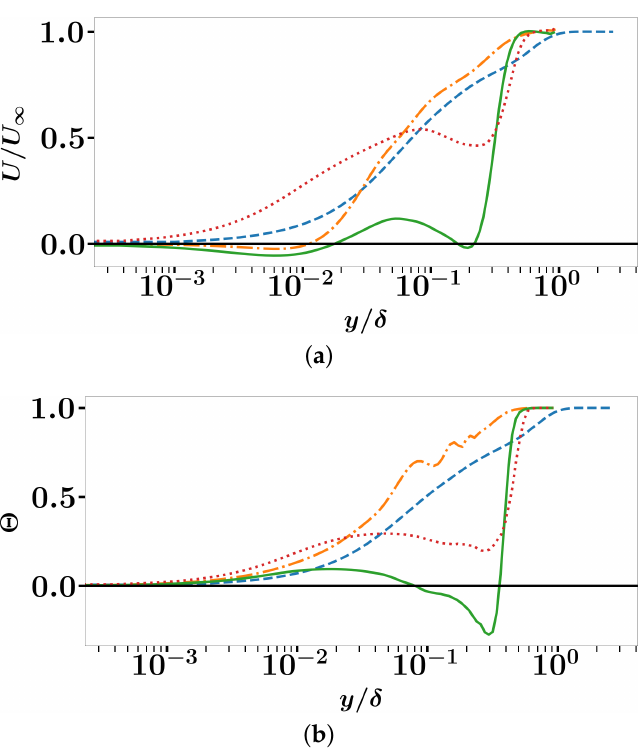
Figure 13. CASE 3: ( a ) mean streamwise velocity in wall units and ( b ) normalized mean temperature (profiles as in the legend of Figure